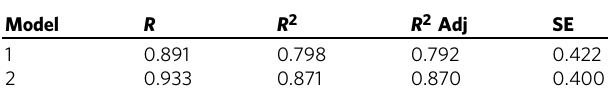
Research fi ndings.